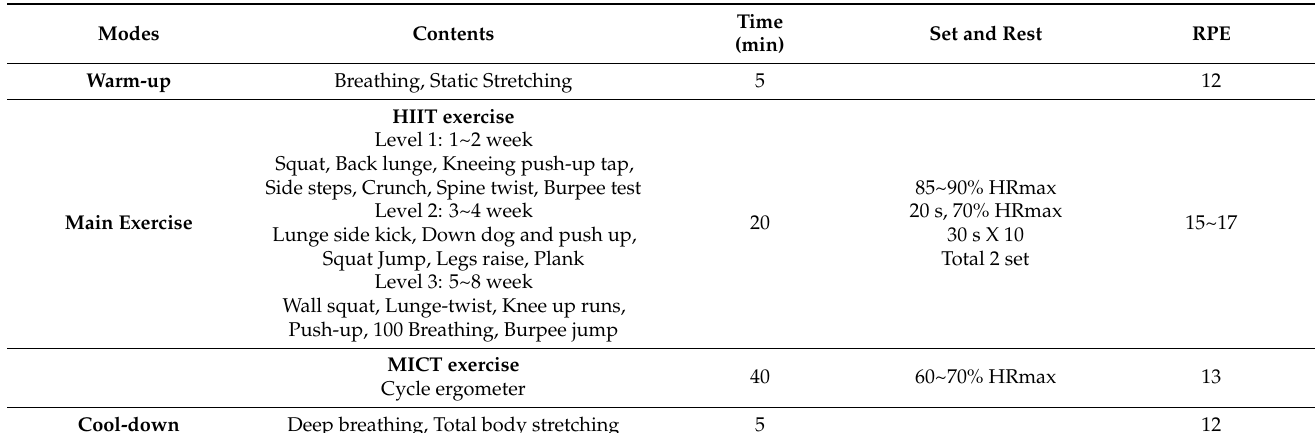
Table 2. High-intensity interval training and moderate intensity continuous training